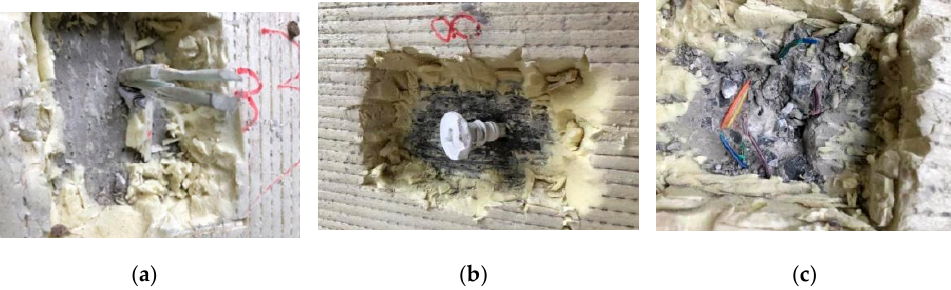
Figure 10. Failure mode of Q1 wallboard connector (part). ( a ) Fiber layer splitting damage; ( b ) fracture at anchorage of connector; ( c ) concrete damage at anchorage.